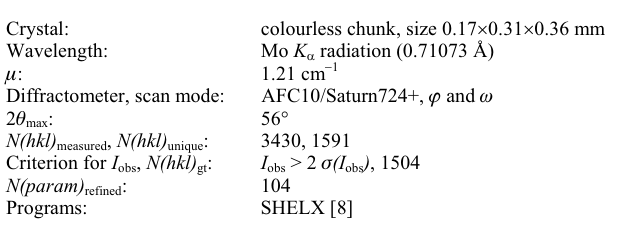
Table 1. Data collection and handling.